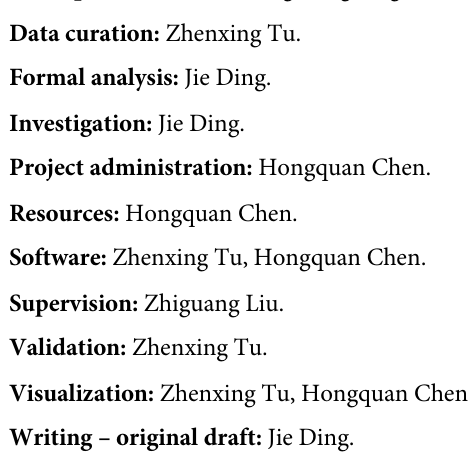
S14 Table. Instrumental variables of triglycerides. The SNP is the result of genetic variants; A1 is the effect allele; A2 is the other allele; beta is the effect size of A1 on the exposure; she is the standard error of beta; pval is the p-value of beta; F is the F statistics. S15 Table. Instrumental variables of HbA1c. The SNP is the result of genetic variants; A1 is the effect allele; A2 is the other allele; beta is the effect size of A1 on the exposure; she is the standard error of beta; pval is the p-value of beta; F is the F statistics. S16 Table. Instrumental variables of fasting glucose. The SNP is the result of genetic vari- ants; A1 is the effect allele; A2 is the other allele; beta is the effect size of A1 on the exposure; she is the standard error of beta; pval is the p-value of beta; F is the F statistics. (PDF) S17 Table. Instrumental variables of 2-h glucose. The SNP is the result of genetic variants; A1 is the effect allele; A2 is the other allele; beta is the effect size of A1 on the exposure; she is the standard error of beta; pval is the p-value of beta; F is the F statistics. S18 Table. Instrumental variables of fasting insulin. The SNP is the result of genetic variants; A1 is the effect allele; A2 is the other allele; beta is the effect size of A1 on the exposure; she is the standard error of beta; pval is the p-value of beta; F is the F